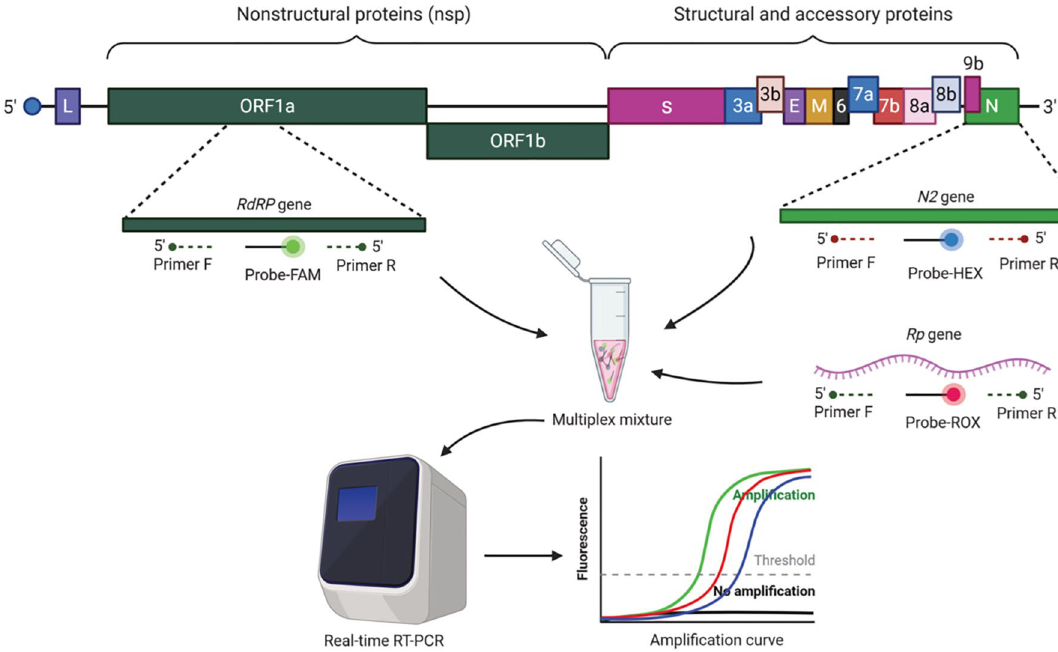
Figure 1. Genome structure of SARS-CoV-2 and the targeted genes in multiplex rRT-PCR